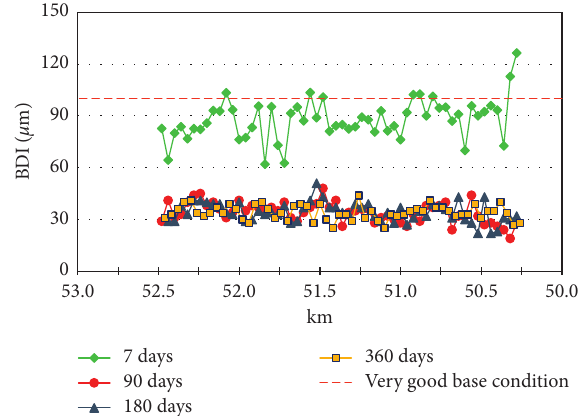
Figure 12: Base Damage Index